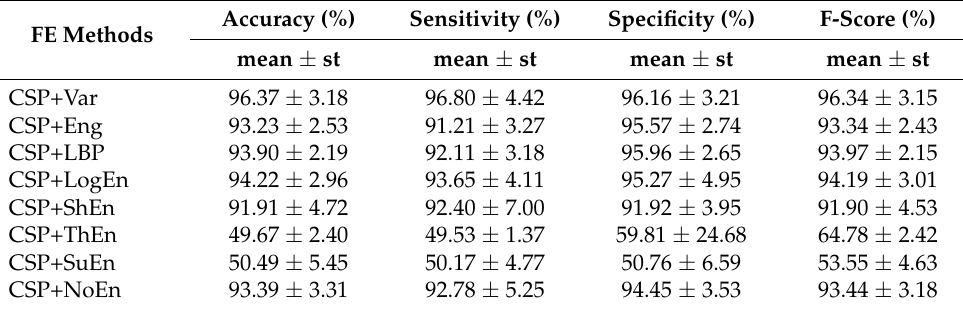
Table 5. Classification results of off–PD vs. HC using KNN classifier (with CSP).